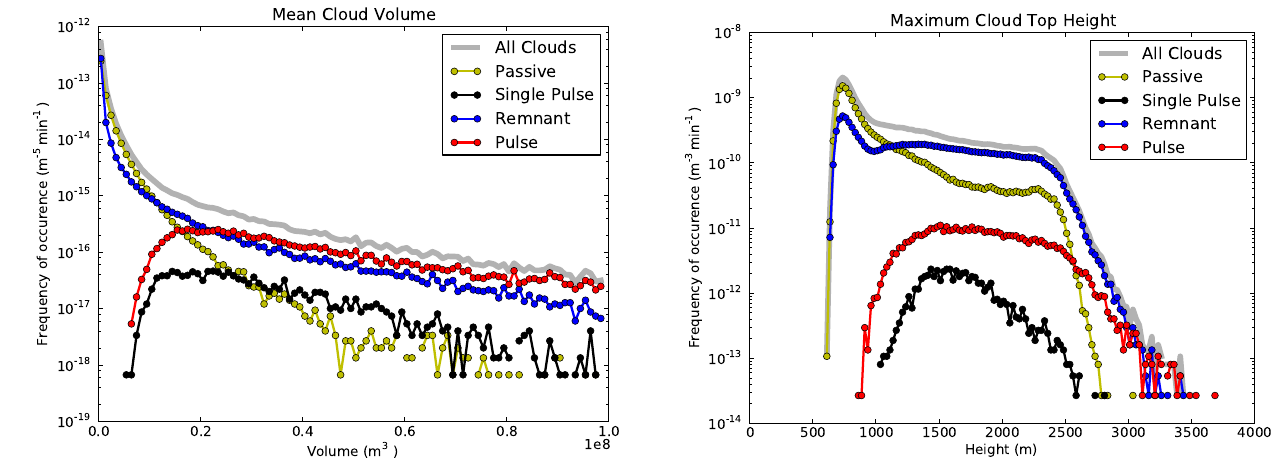
Fig. 10. Histogram of the mean volume for all clouds, and for the different cloud types.